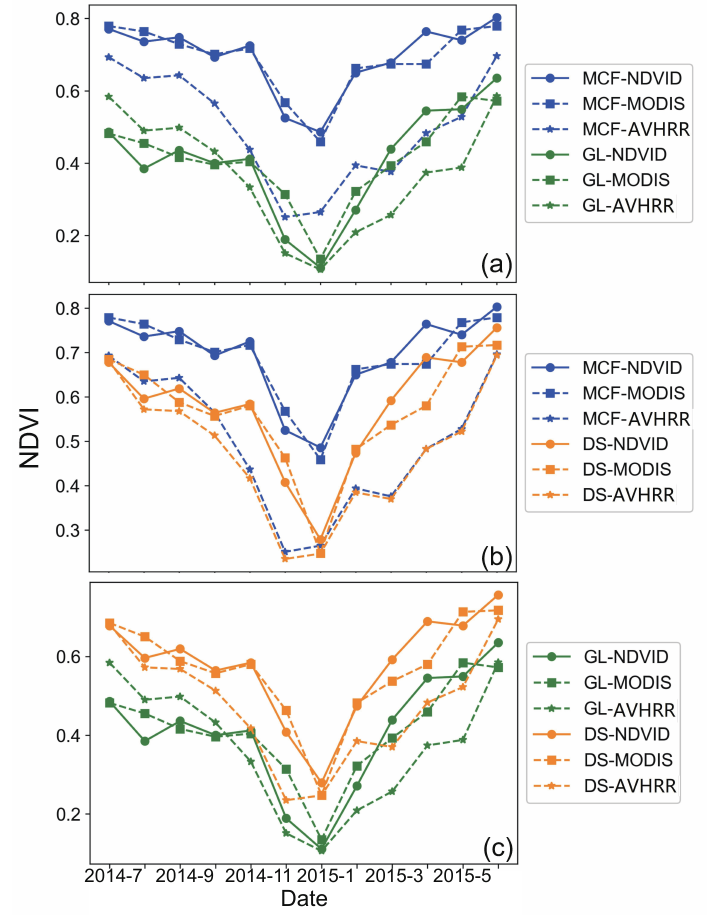
Figure 9. Performance comparison of the three NDVI datasets for distinguishing different vegetation types in Idaho state: ( a ) mixed conifer forest (MCF) versus grassland (GL), ( b ) mixed conifer forest (MCF) versus deciduous shrubland (DS), and ( c ) grassland (GL) versus deciduous shrubland (DS). Each point represents the NDVI estimates from the MODIS, downscaled (NDVI), or AVHRR NDVI datasets for every month from one